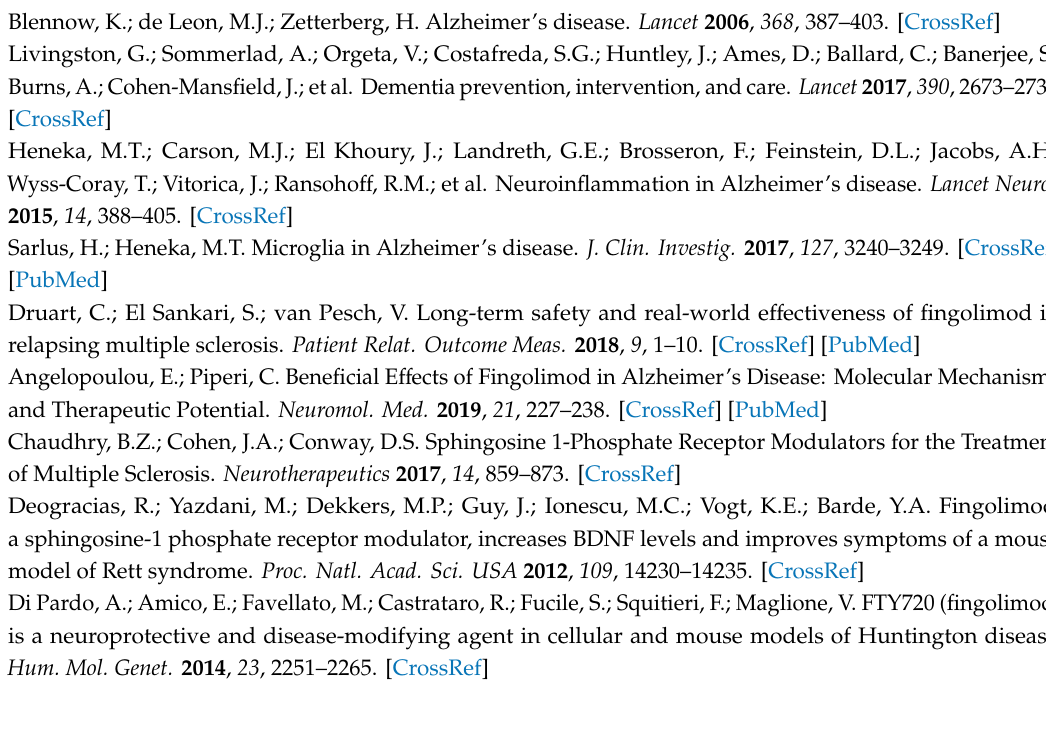
Figure S1: Absence of any changes in synaptic fatigue during LTP induction, in post-tetanic potentiation, in Cue task motor parameters and training performance on day 1 during Morris Water Maze experiments upon fingolimod (FTY720) treatment. Figure S2: Unchanged mean fluorescence intensity per area of microglial and astroglial cells in hippocampus and cortex upon fingolimod (FTY720) treatment. Figure S3: No increases in BDNF protein levels or TrkB signaling in fingolimod treated APP / PS1 mice. 5–6 months old male APP / PS1 mice were treated with i.p. injections of fingolimod for 1-2 months. Figure S4: Dependence of CA1 pyramidal neuron spine density from distance to A β plaques in APP / PS1 (AD) mice. 5–6 months old male APP / PS1 mice were treated with i.p. injections of vehicle or fingolimod for 1–2 months. Figure S5: Improvement in MWM training performance between the four treatment groups. 5–6 months old male APP / PS1 mice were treated with i.p. injections of vehicle or fingolimod for 1–2